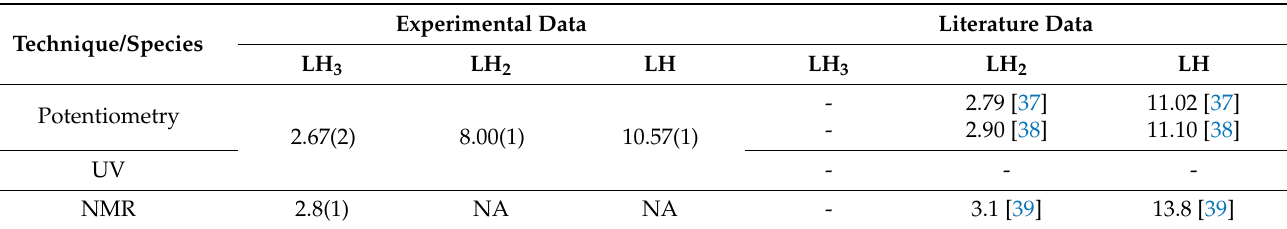
Table 1. Protonation constants of metformin at 25 ◦ C, 0.1 M NaCl ionic strength, obtained using the HypSpec2014 [32] pro- gram for combined potentiometric and spectrophotometric measurements and HypNMR [36] for 1 H-NMR measurements. NA = not applicable due to insufficient